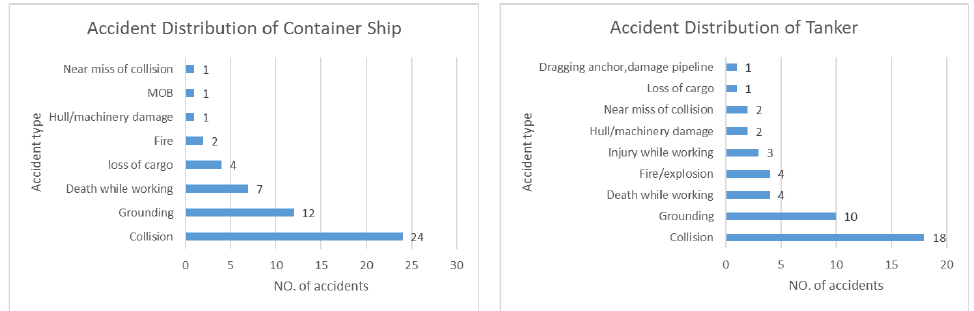
Figure 10. Accident distribution of bulk carriers ( left ) and fishing vessels ( right ). Figure 11. Accident distribution of cruise ships ( left ) and passenger ships ( right ). 3. Domino Effect Model Based on TAR The temporal association rule mining algorithm was originally developed by Das, G. [18]. It is a widely used machine learning algorithm that adds a time dimension to the association rule algorithm in order to mine and discover hidden relationships between and within different types of accidents from the perspective of the domino effect, as well as revealing its triggering patterns between correlated factors and accidents. It can be ex- pressed as follows: ( ) X Y t → (1) where X represents an event pattern and Y represents another event pattern; it indicates that when X occurs, Y is likely to occur within t time. The three key indicators of the temporal association rule are support, confidence, and lift. Support S denotes the likelihood that both X and Y(t) occur in the same transaction,